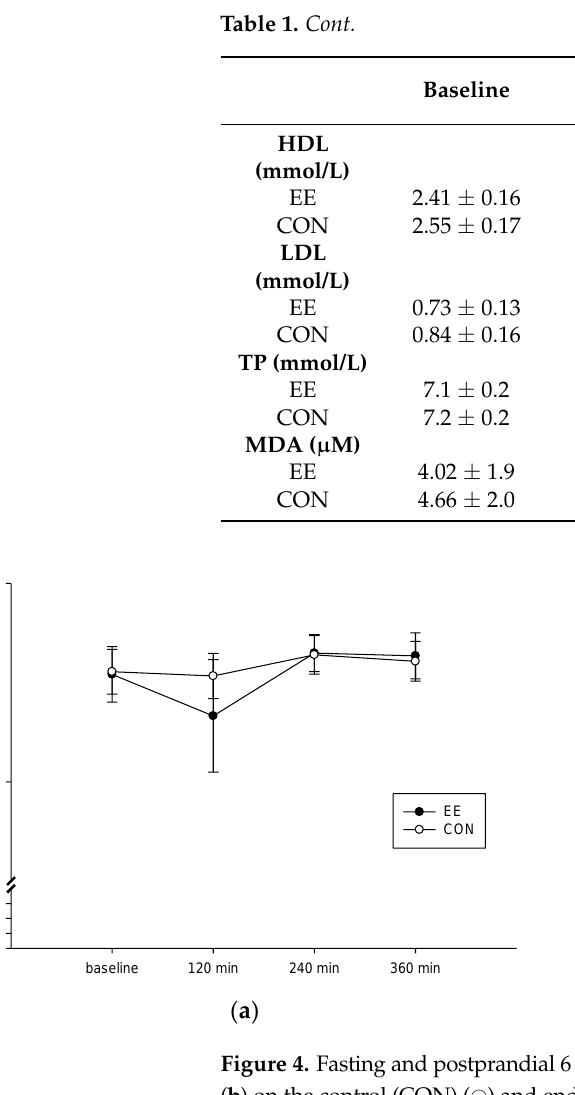
Table 1. The total cholesterol (TCHO), high-density lipoprotein (HDL), low-density lipoprotein (LDL), malondialdehyde (MDA), and total protein (TP) levels in the blood plasma. Baseline